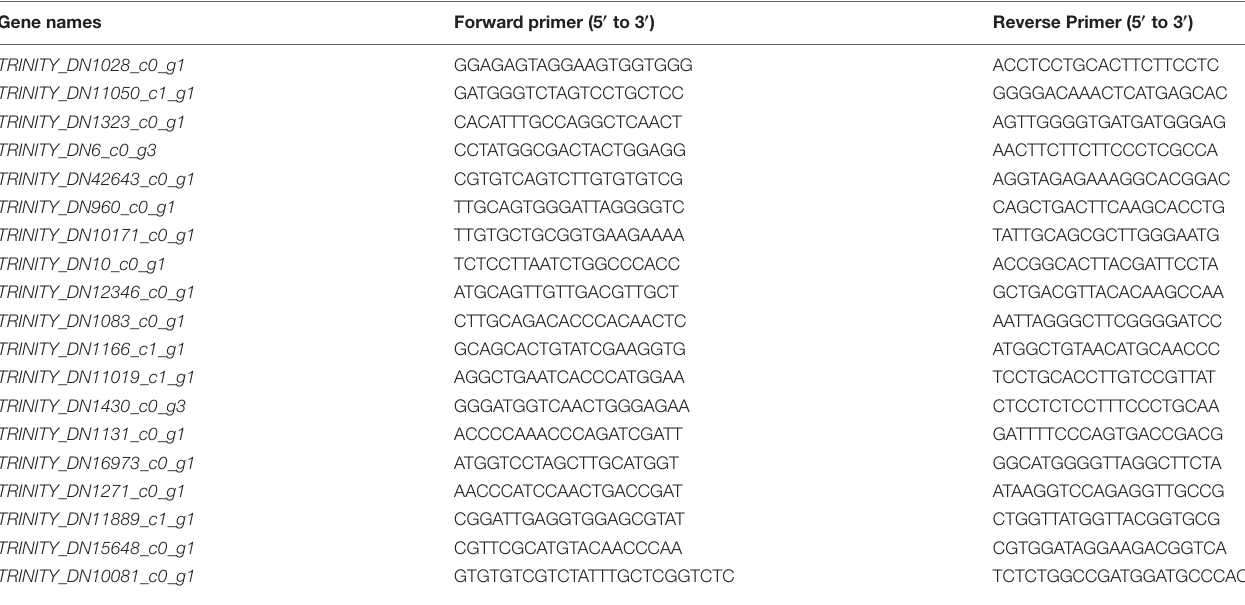
TABLE 2 | Primers used in